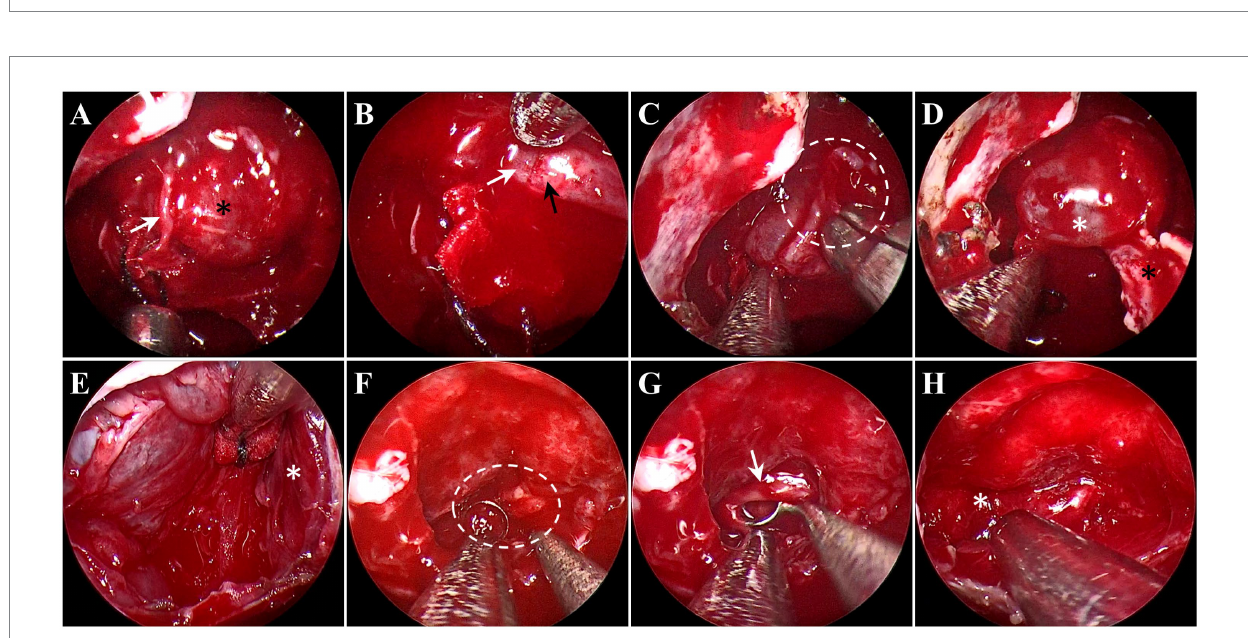
FIGURE 1 Endoscopic intraoperative views in the areas with pseudocapsule. (A) The surgical dissection plane was being established; the opened dura mater (black arrow) and the opened pituitary capsule (white arrow). (B) The pseudocapsule (white arrow) was being opened. (C) Internal decompression of tumor. (D) The remaining tumor shell was removed (white asterisk).